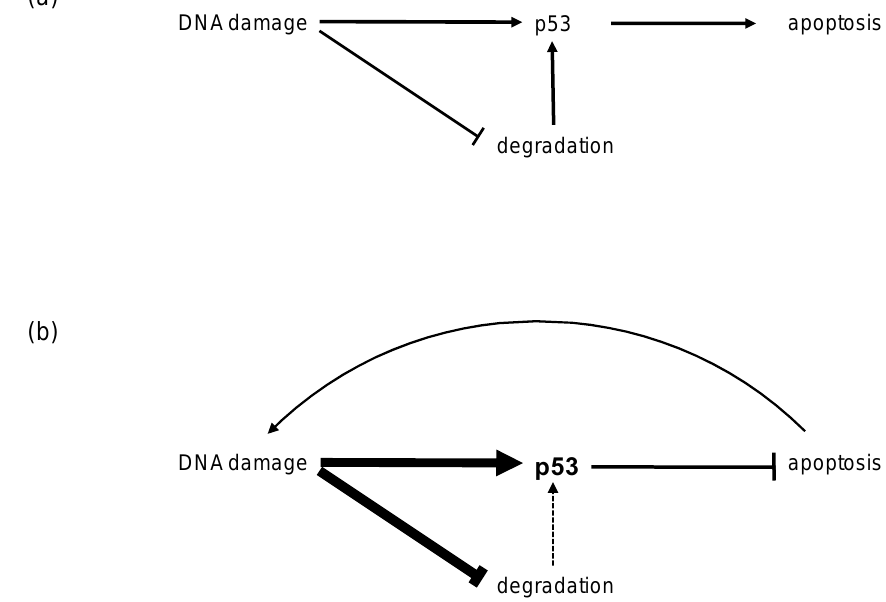
Figure 1. Normal and feedback regulation of p53: ( a ) Usually, after cellular stresses p53 stabilization is regulated through posttranslational modifications (PTMs) and inhibition of proteasomal degradation, resulting in apoptosis. ( b ) Derogation of the p53 depended apoptotic cascade results in activation of positive feedback loops that enhance (fat arrows) p53 stabilization and inhibition of degradation to induce apoptosis. Thus, accumulation of wildtype p53 and nonregulation of apoptosis results from lack of function.